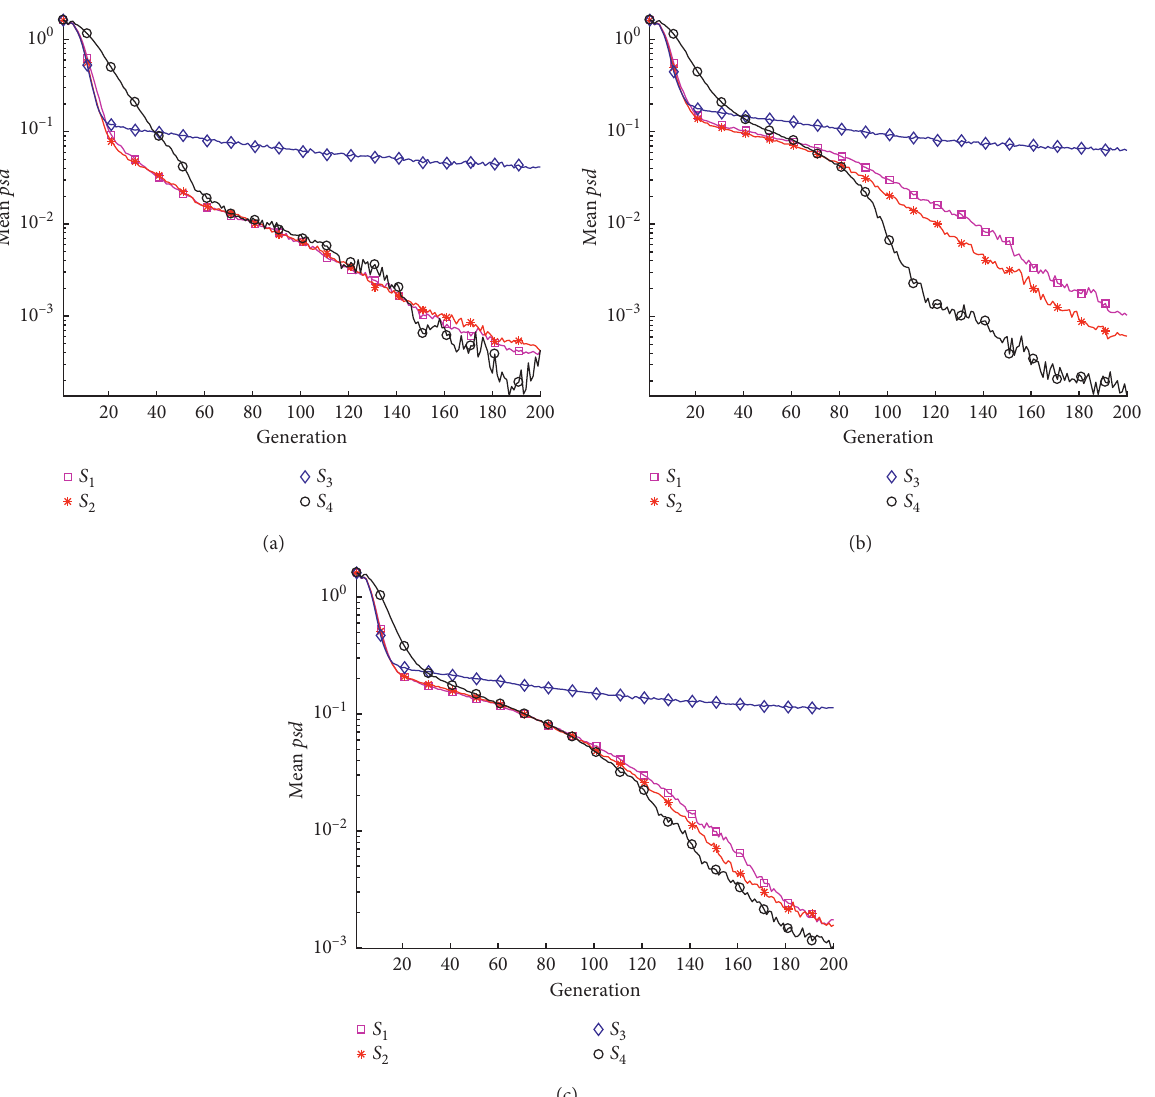
Figure 4: Mean psd during the run time of four fitness functions for three defective cases. (a) Case (A). (b) Case (B). (c) Case C.